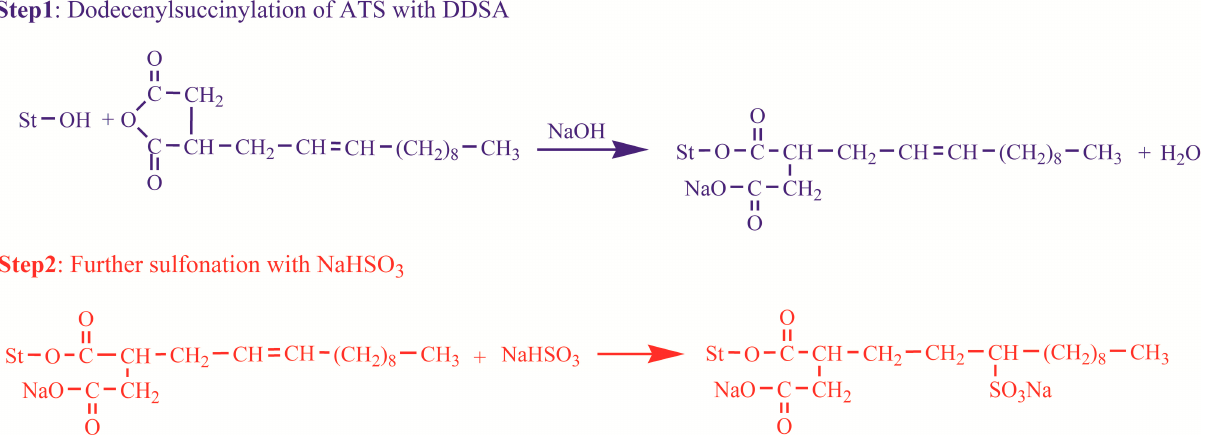
Table 1. Characterization of starch sulfododecenylsuccination.